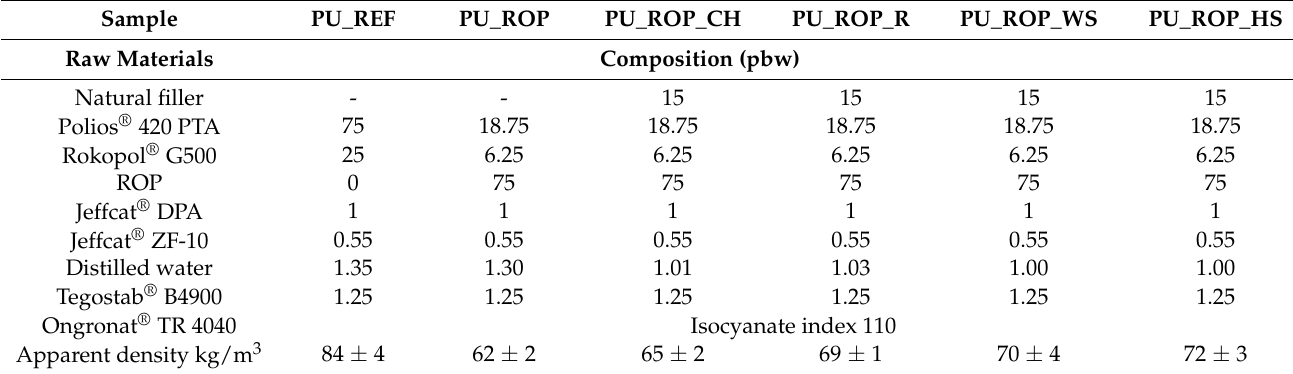
Table 1. Summary of RPUF formulations used in the study (amounts in parts by weight -